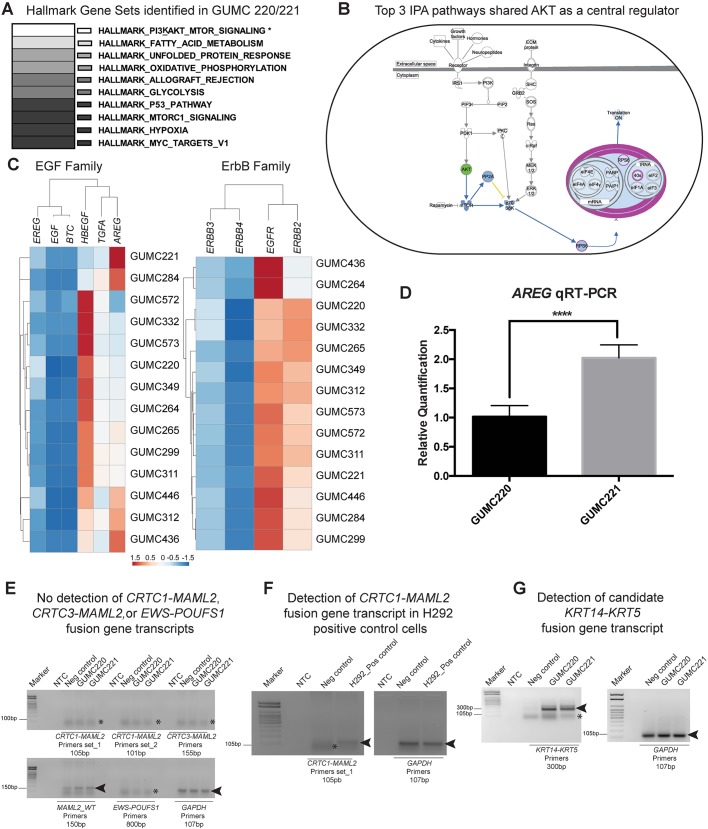
Transcriptome characterization of GUMC220 and GUMC221 MEC primary cells demonstrated evidence of PI3K-AKT-mTOR­
signaling activation and presence of a candidate KRT14-KRT5 fusion. (A) Top 10 Hallmark gene sets (MSigDB) identified from genes showing ≥500 FPKM. The top 10 pathways were identical in GUMC220 and GUMC221. Only PI3K-AKT-mTOR signaling was significantly associated with GUMC220/221 compared to the six other paired culture transcriptomes analyzed (four pleomorphic adenomas: GUMC284/299, GUMC332/349, GUMC436/446, GUMC572/573; one metastatic squamous to parotid: GUMC264/265; one submandibular lymphoma: GUMC311/312). *P<0.05, two-tailed Fisher’s exact test. (B) Top three canonical pathways identified by IPA shared AKT as a central regulator. (C) Dendrograms and heat maps of unsupervised hierarchical clustering of FPKM values of genes from EGF (EREG, EGF, BTC, HBEGF, TGFA, AREG) and ErbB (ERBB3, ERBB4, EGFR, ERRB2) families. (D) AREG expression in GUMC220 and GUMC221 cells, evaluated by qRT-PCR. ****P<0.0001, two-tailed Student's t-test, n=3. Data are mean±s.e.m. (E) Ethidium bromide-stained agarose gels showing absence of detection of CRTC1-MAML2, CRTC3-MAML2 and EWS-POUFS1 fusions (asterisks indicate primer dimers) and detection of MAML2-WT and GAPDH (arrowheads) by RT-PCR in GUMC220 and GUMC221 cells. Predicted product sizes are included under each primer label. (F) Ethidium bromide-stained agarose gels showing detection of CRTC1-MAML2 in H292 cell line as a positive control (arrowheads). Asterisks indicate primer dimers. Predicted product sizes are included under each primer label. (G) Ethidium bromide-stained agarose gels showing detection of candidate KRT14-KRT5 fusion and GAPDH (arrowheads) in GUMC220 and GUMC221 cells. Asterisks indicate primer dimers. AREG, amphiregulin; AKT, protein kinase B; BTC, betacellulin; CRTC1, CREB regulated transcription coactivator 1; CRTC3, CREB-regulated transcription coactivator 3; EGFR, epidermal growth factor receptor; ERBB2, Erb-B2 receptor tyrosine kinase 2; ERBB3, Erb-B2 receptor tyrosine kinase 3; ERBB4, Erb-B2 receptor tyrosine kinase 4; EREG, epiregulin; PI3K, phosphatidylinositol-4,5-bisphosphate 3-kinase; EWS, Ewing's sarcoma gene; EGF, epidermal growth factor; HBEGF, heparin binding EGF-like growth factor; MAML2, mastermind-like transcriptional coactivator 2; mTOR, mechanistic target of rapamycin; Neg control, negative control (GUMC-UMB-006 cells isolated using CRC from normal human tongue); NTC, no template control; Pos control, positive control; POUFS1, POU class 1 homeobox 1; TGFA, transforming growth factor alpha.